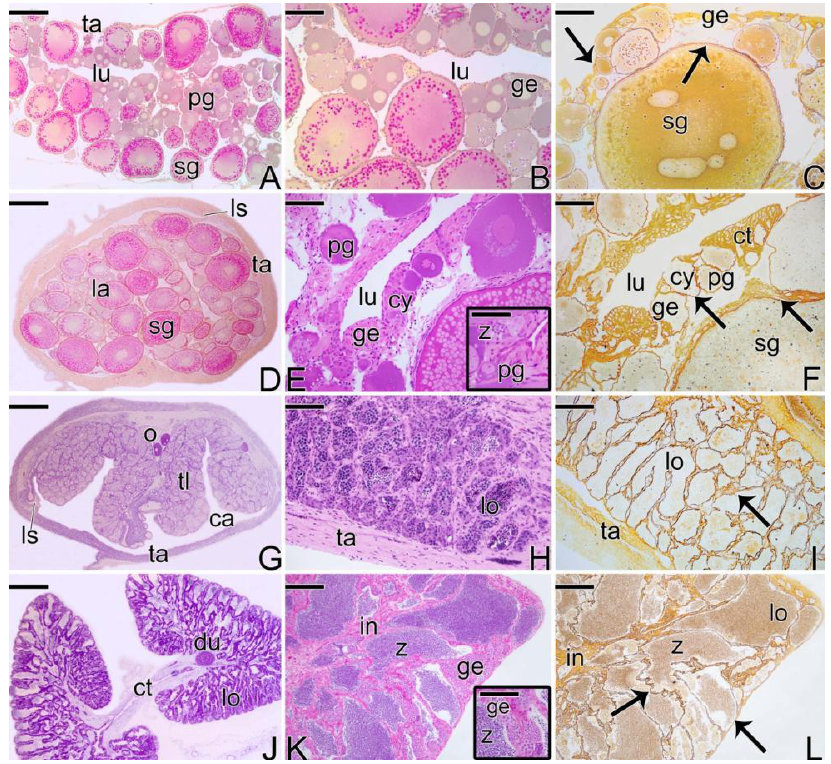
Figure 1. Four types of gonadal structures present in S. marmoratus : ( A – C ) Longitudinal section of